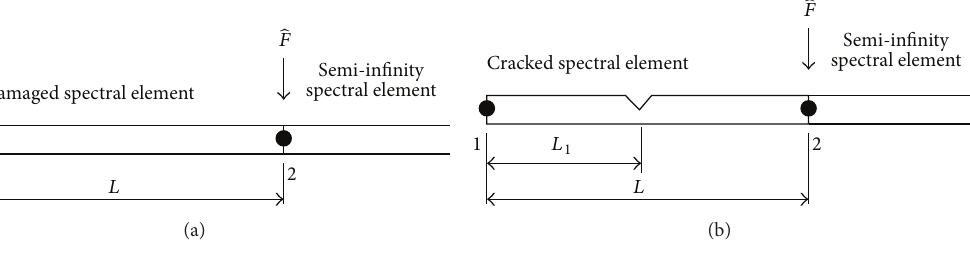
Figure 6: Undamaged (a) and damaged (b) structural models.